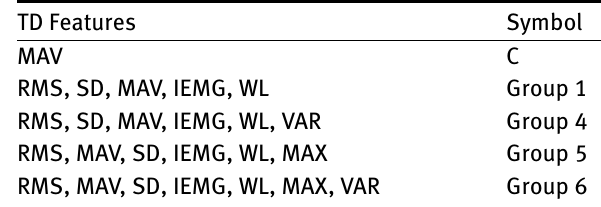
Table 1: All TD feature sets used in this